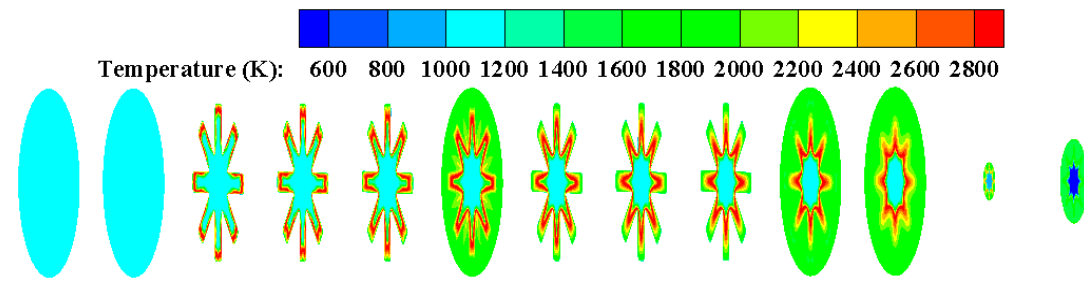
Figure 14. Temperature distribution in the motor for case seg-1/2-40.